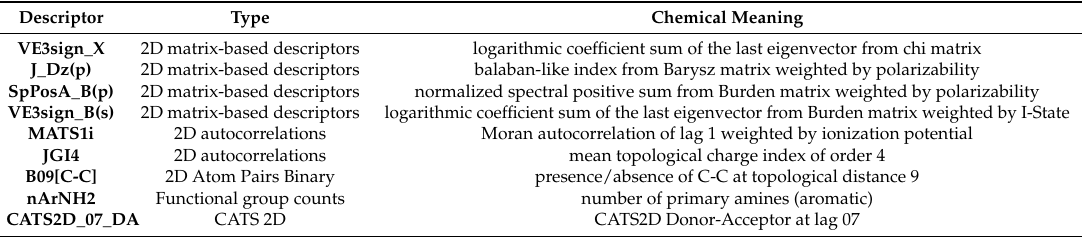
Table 1. Types and chemical meanings of molecular descriptors used in model II